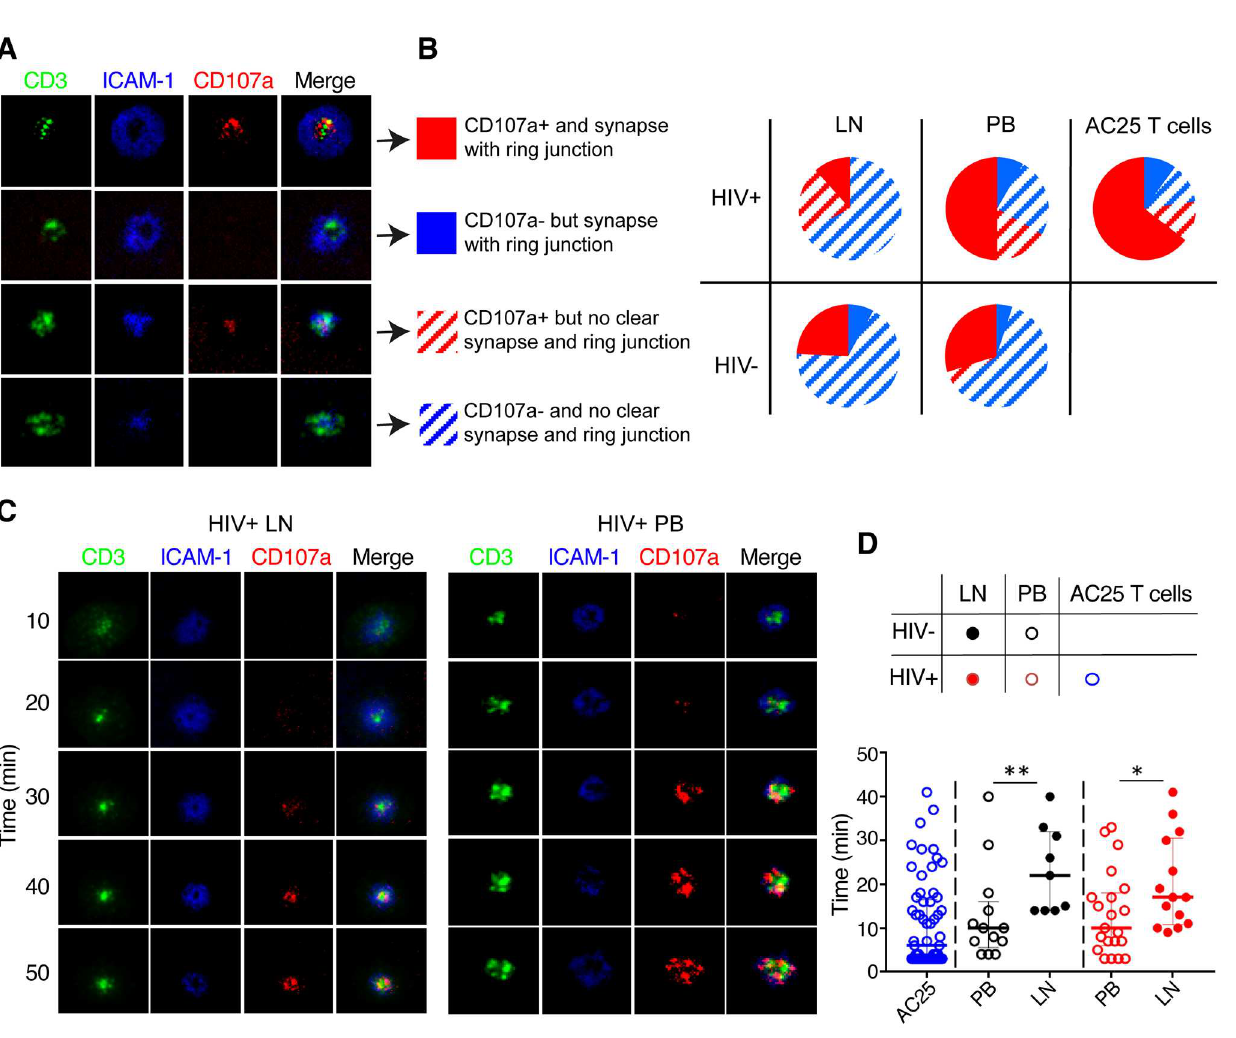
Fig 7. Synaptic interface, degranulation pattern and kinetics of degranulation by LN and blood CD4+ T cells. Freshly isolated CD4+ T cells were exposed to planar lipid bilayers containing fluorescent labeled ICAM-1 and anti-CD3 antibodies and the structure of the T cell/bilayer interface and pattern and kinetics of degranulation were analyzed by TIRF microscopy. ( A ) Representative images of T cell/bilayer interface demonstrating patterns of accumulation and segregation of TCR and integrin molecules and the appearance of CD107a proteins at the interface are shown. The cells fall into 4 different groups: 1) T cells demonstrating the formation of classical cytolytic synapse containing central (cSMAC) domain, peripheral ring junction (pSMAC), and centrally located CD107a indicating granule release (solid red); 2) T cells showing the formation of cytolytic synapse without detectable granule release (solid blue); 3) T cells that are characterized by aggregation of TCR and integrin molecules without formation of mature cytolytic synapse, but with detectable granule release (red stripes); 4) T cells that display overlapping aggregates of TCR and integrin molecules without granule release (blue stripes). ( B ) Diagrams showing representation of LN- and PB-derived T cells of HIV-infected ART- and uninfected individuals with different structure of synaptic interfaces and patterns of granule release displayed in panel ( A ); HIV-specific cloned CD4+ T cells AC25 are shown for comparison reasons. ( C ) Time-dependent changes of the structure of T cell/bilayer interfaces and appearance of the released granules for representative T cells derived from LN and PB are shown. ( D ) Quantitation of the kinetics of granule release by LN (closed circles) and PB (open circles) CD4+ T cells isolated from HIV-infected ART- (red circles) and uninfected (black circles) individuals. The kinetics of granule release by HIV-specific T-cell clone AC25 is shown for comparison reasons (depicted by open blue circles). Each individual circle designates first appearance of detectable granule release by individual cells. Median and IQR are shown for all scatter plots. Mann-Whitney tests were performed to compare differences between indicated groups of T cells; (cid:3) P < 0.05, (cid:3)(cid:3) P < 0.01. Through access to cohorts with time points from before and after HIV infection we now show that the frequencies of effector CD4+ T cells increase longitudinally after HIV infection and that in peripheral blood these cells are not depleted during chronic HIV infection. The reason for